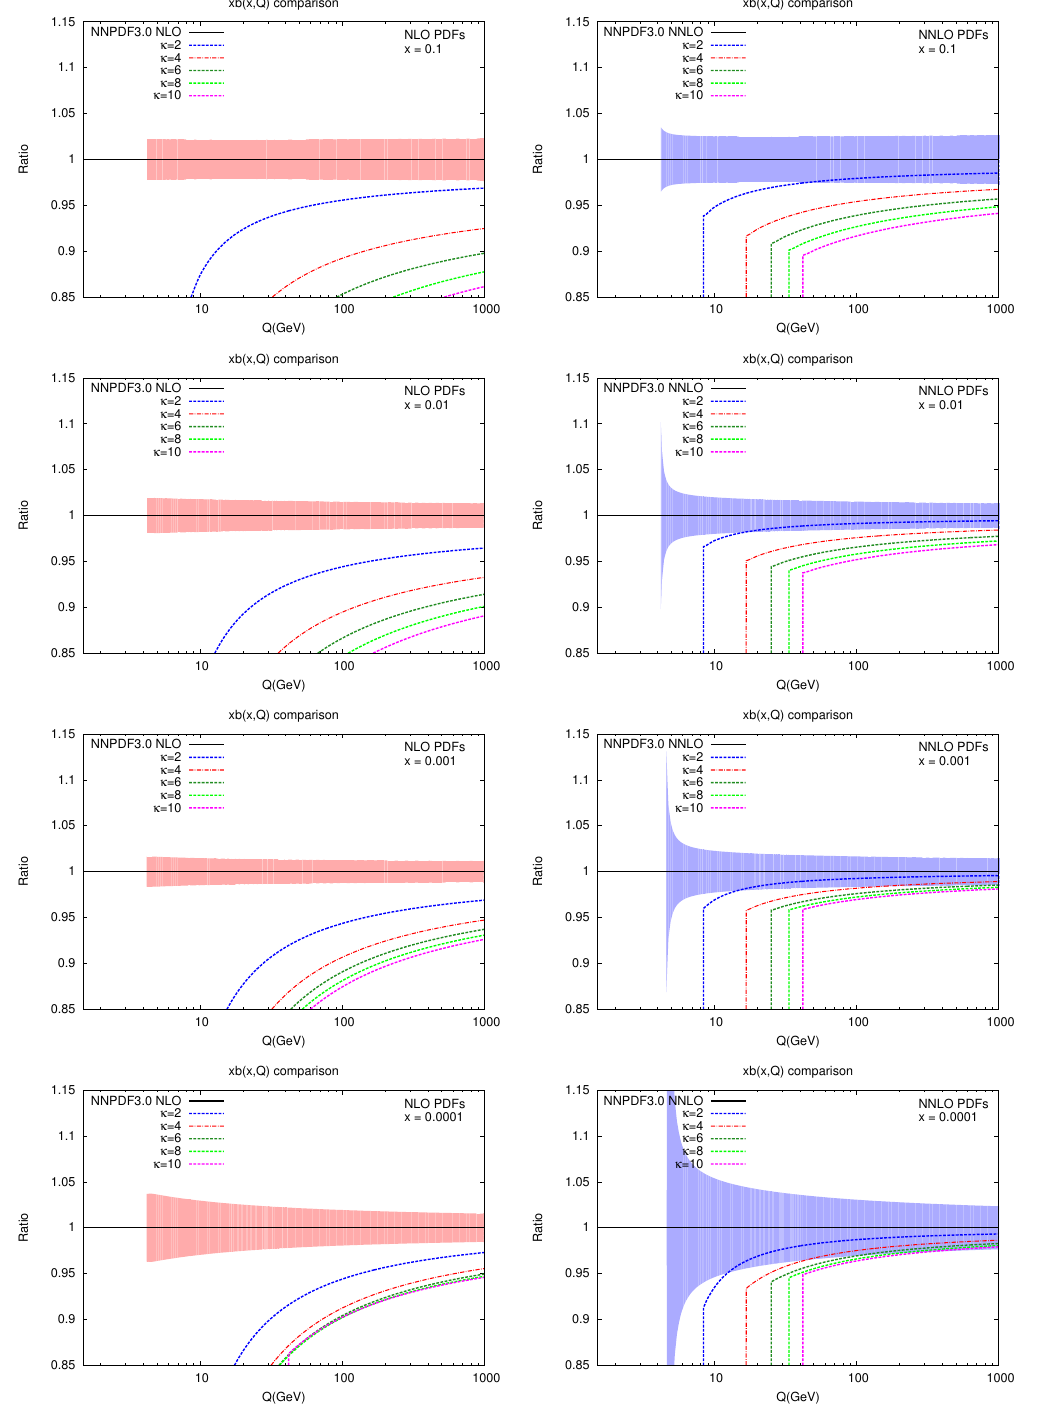
Figure 14 . As in (cid:12)gure 13 but for the bottom